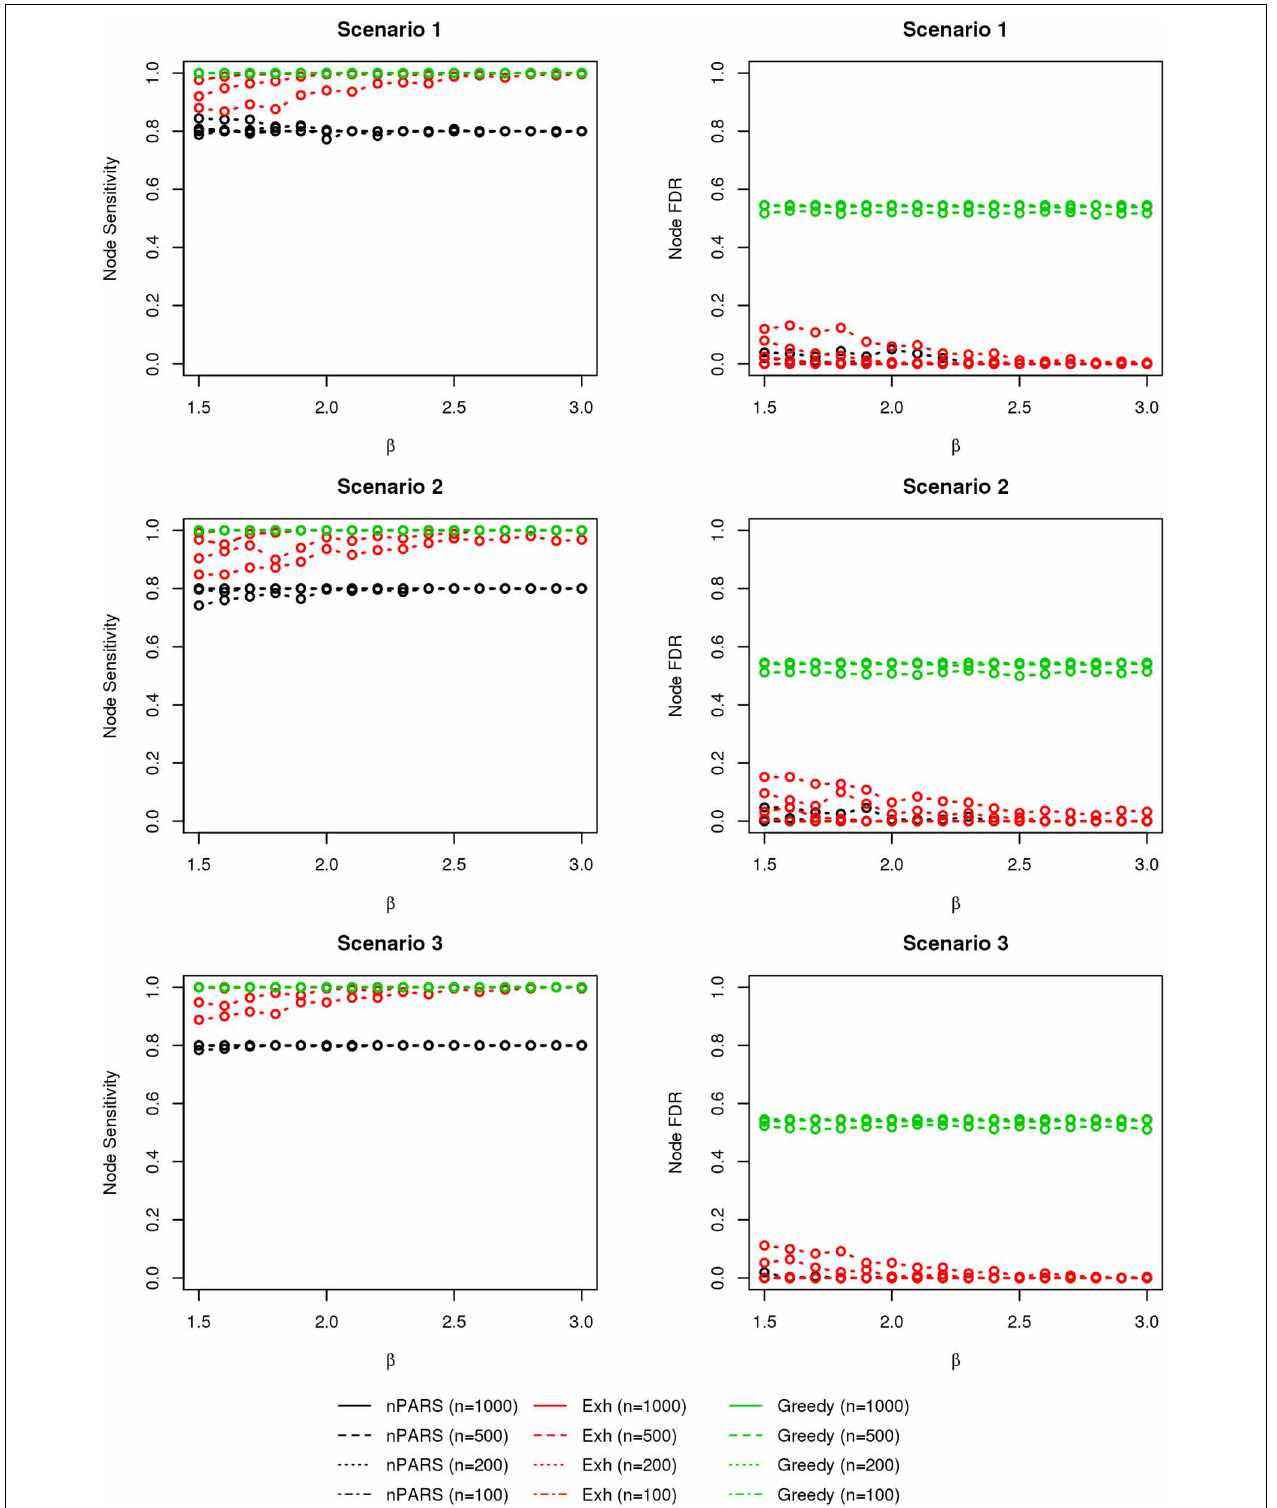
FIGURE 4 | The sensitivity and FDR of node comparisons in simulation scenario 1–3. nPARS shows lowest node FDR with slightly lower node sensitivity compare to exhaustive search. Although greedy search exhibits highest node sensitivity but it reports relatively high node FDR.